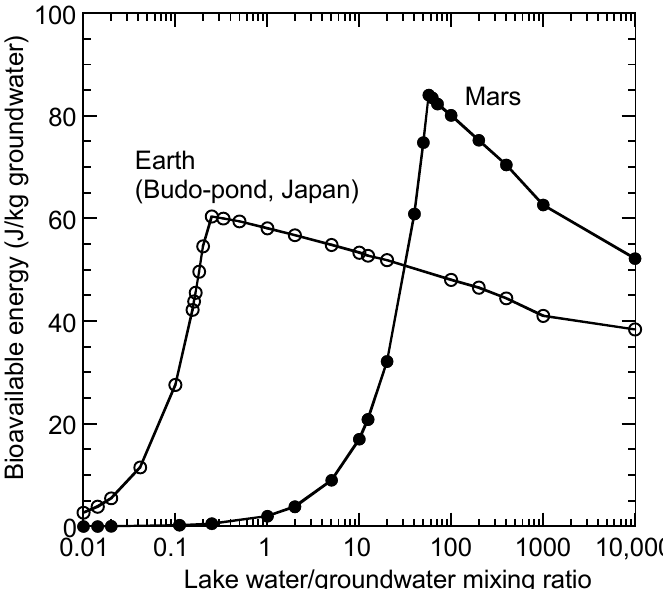
Figure 8. Bioavailable energy (J/kg groundwater) of aerobic Fe 2+ -oxidizing magnetite formation as a function of surface water-to-groundwater mixing ratio.